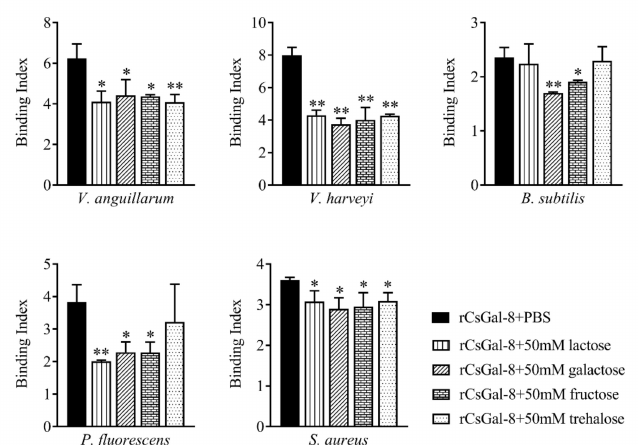
Figure 7. Inhibition effects of different carbohydrates on rCsGal-8 binding to bacteria. rCsGal-8 was pre-incubated with lactose, galactose, fructose, trehalose, or PBS (control), and the binding to different bacteria ( Vibrio anguillarum , Vibrio harveyi , Pseudomonas fluorescens , Staphylococcus aureus , and Bacillus subtilis ) was determined by ELISA. Values are the means of three experimental replicates and shown as means ± S.D. * p < 0.05, ** p < 0.01.